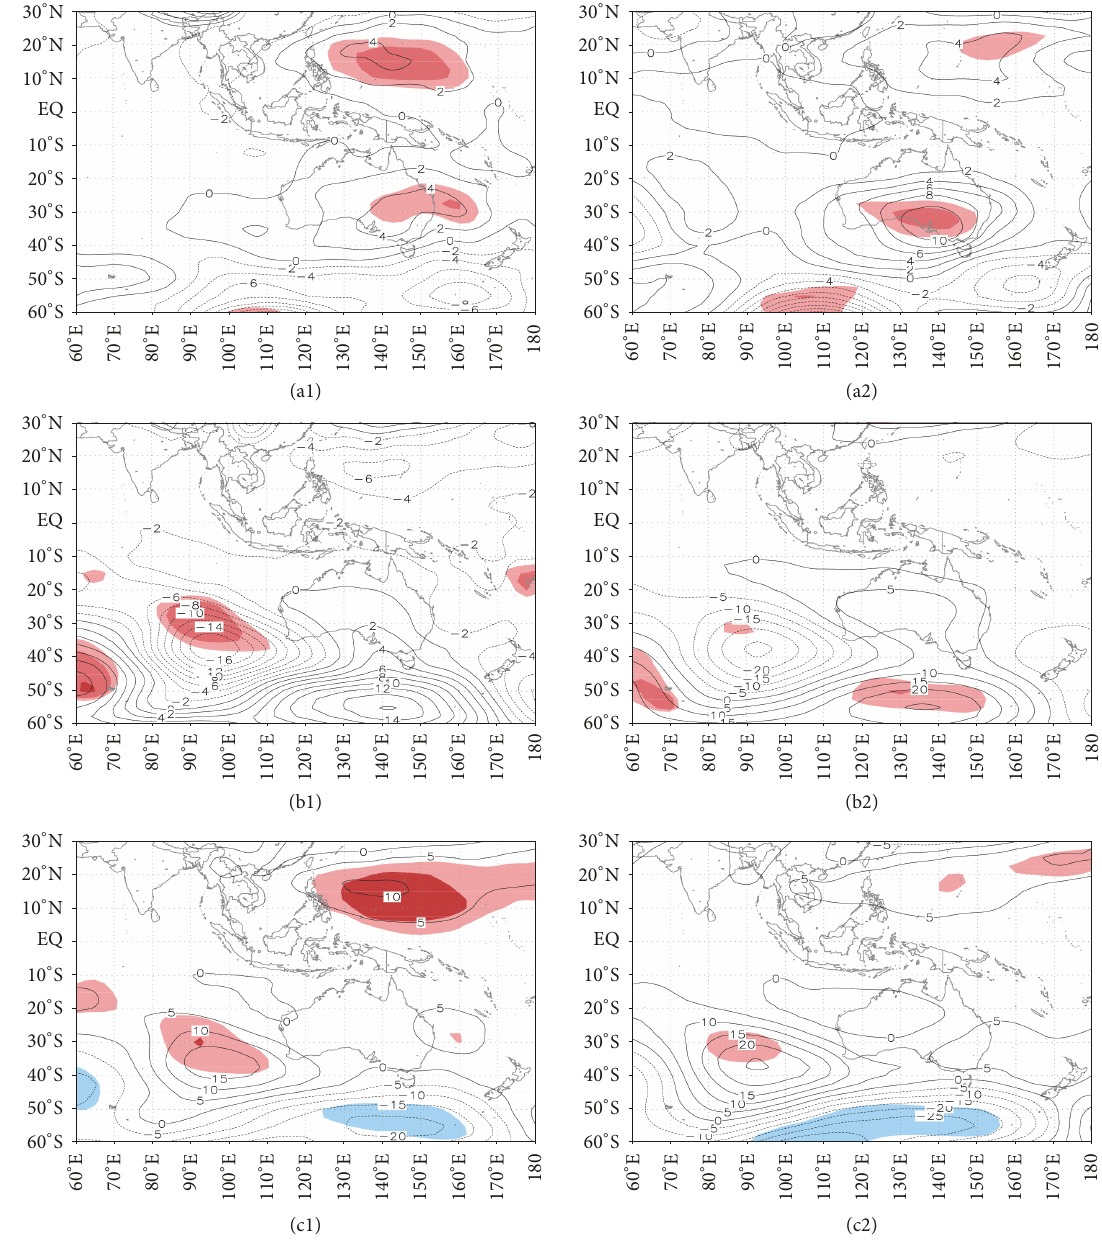
Figure 6: Composite distributions of the GH anomalies in the prerainy season in South China. The panels on the left correspond to the values at 850 hPa in flood years (a1) and drought years (b1) and the 𝑡 -test results of the 𝐷 -values between flood and drought years (c1). The corresponding panels on the right show the same results, but at 500 hPa. Significant values exceeding the 90%, 95%, and 99% confidence levels ( 𝑡 -test) are